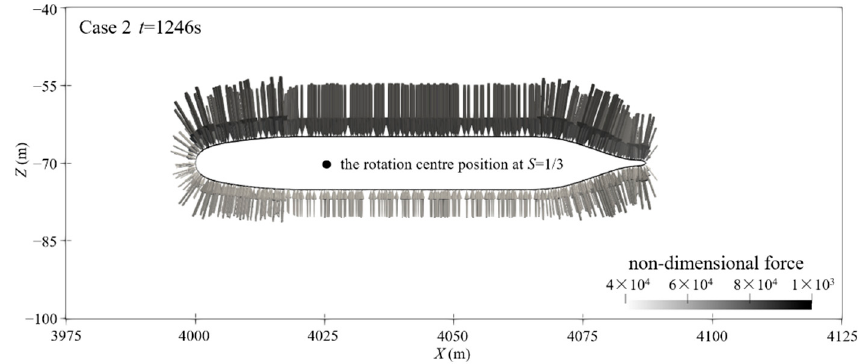
Figure 17. Nondimensional force vector around the SUBOFF.